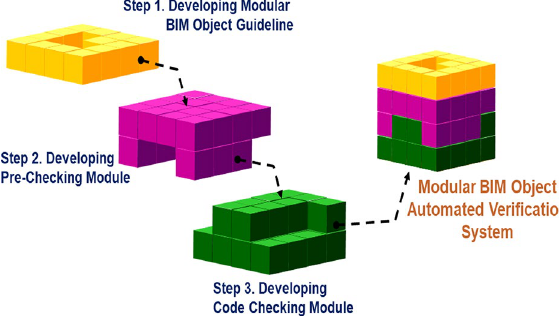
Figure 1. Process of developing modular BIM objects automated verification system (Sun & Kim,